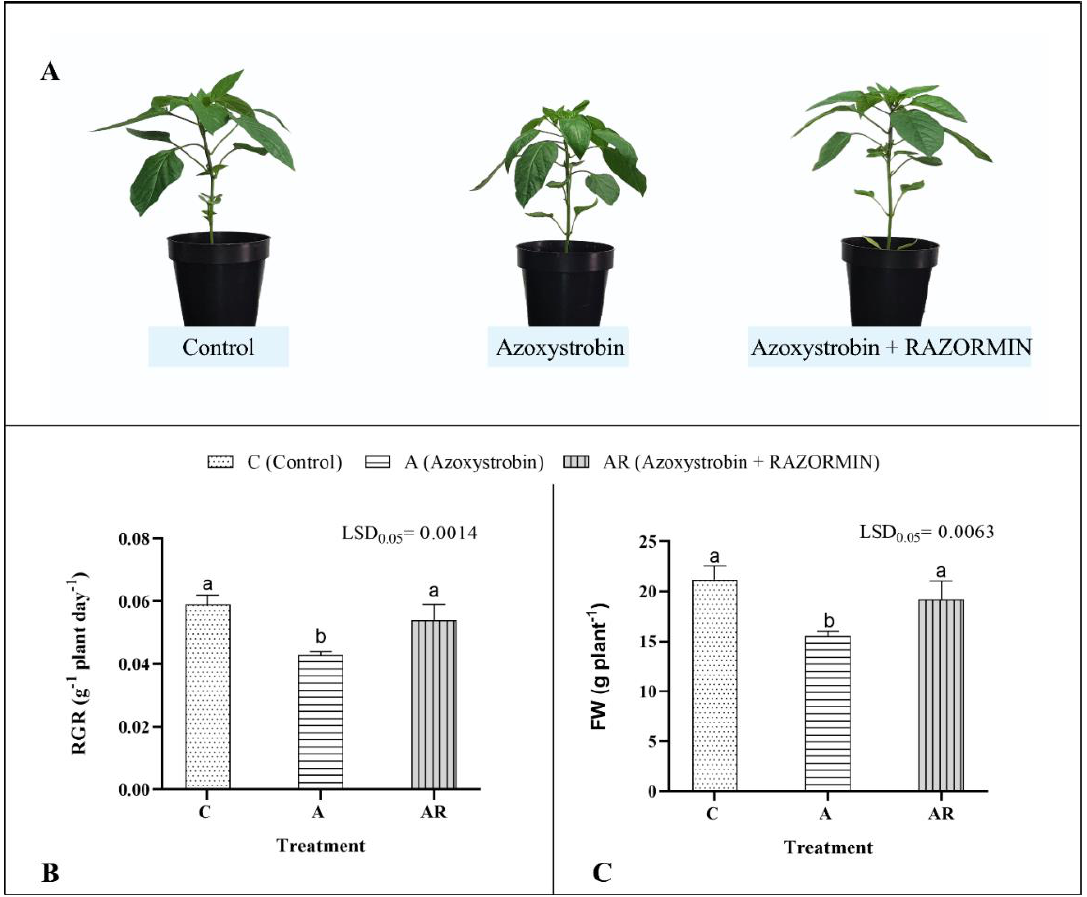
Figure 2. Effect of the biostimulant RAZORMIN ® application on pepper plants subjected to the application of the fungicide Azoxystrobin: phenotypic appearance of the plants ( A ), relative growth rate of the aerial part ( B ), and production of fresh biomass of the aerial part ( C ). Abbreviations; RGR: relative growth rate; FW: fresh weight. All the data values represent means ± SD, ( n = 9). Fisher’s least-significance test (LSD; p = 0.05) was undertaken to analyze the differences between the means. Different letters indicate significantly different values. Table 7. Effect of the application of biostimulant RAZORMIN ® on some parameters of chlorophyll a fluorescence in pepper plants subjected to the fungicide Azoxystrobin.